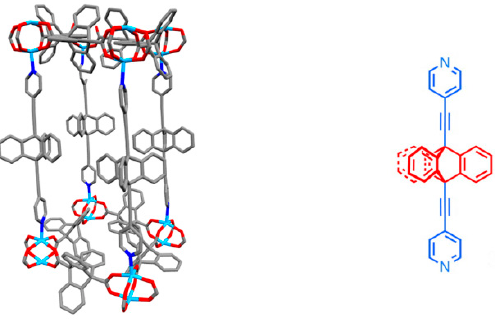
Figure 9. Crystal structure of UCLA-R3 ( left ); the triptycene rotator is shown in red ( right ). Adapted with permission from [33]. Copyright American Chemical Society, 2016.